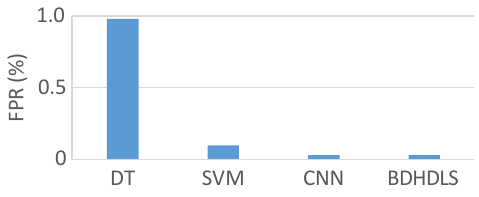
Fig. 16 FPR for the DARPA1998 dataset.